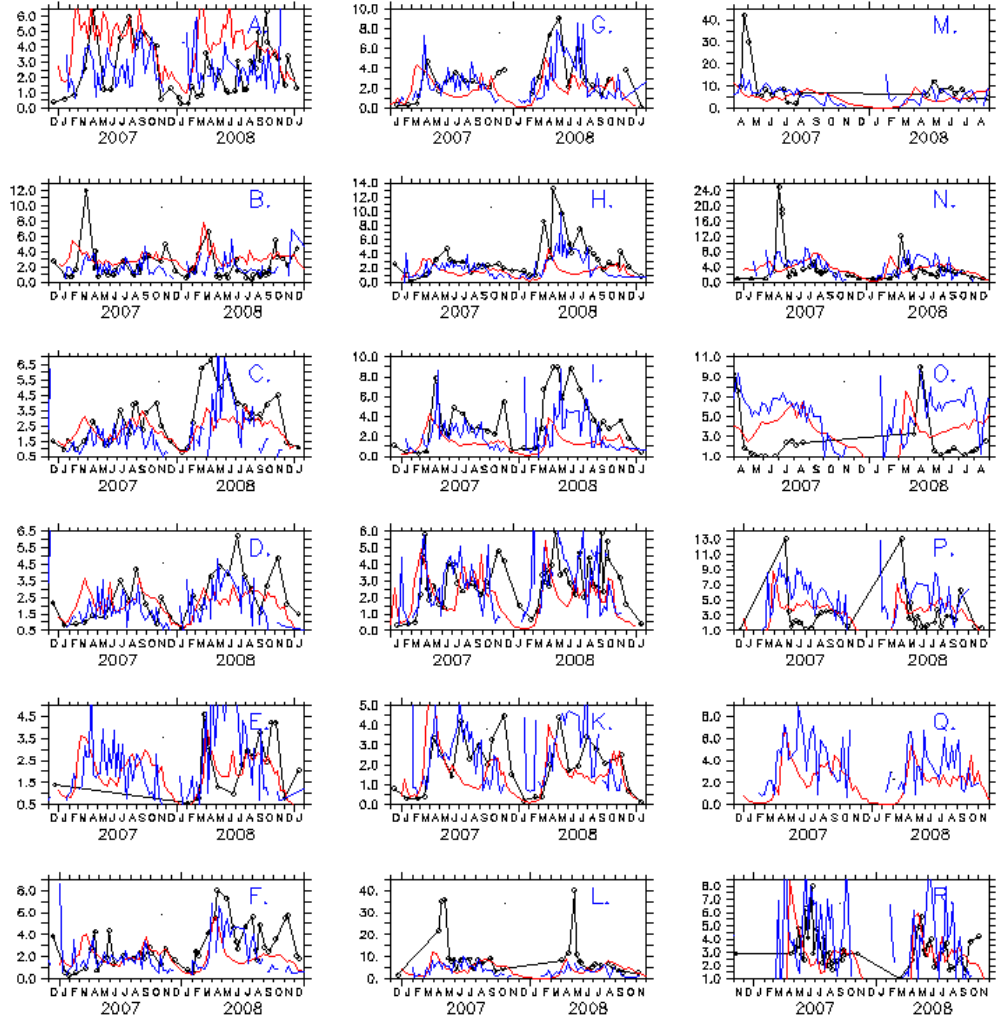
Fig. 17. Inter-comparison among modeled, satellite detected and in-situ observed Chl a in surface layer. Blue solid curve for satellite detected results. Other notations same as in Fig.